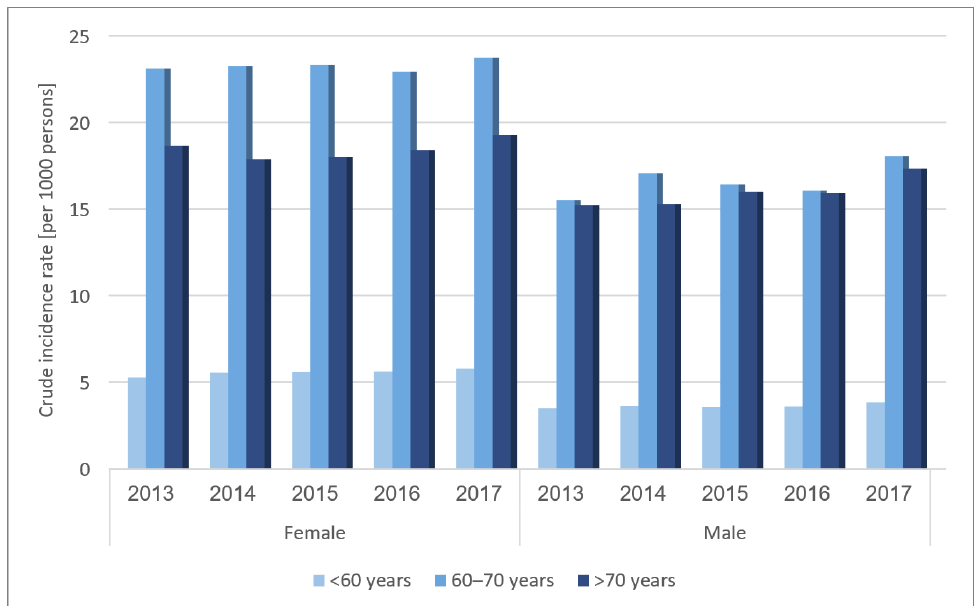
Figure 3. Trends for OA incidence between 2013 and 2017, by age and sex.